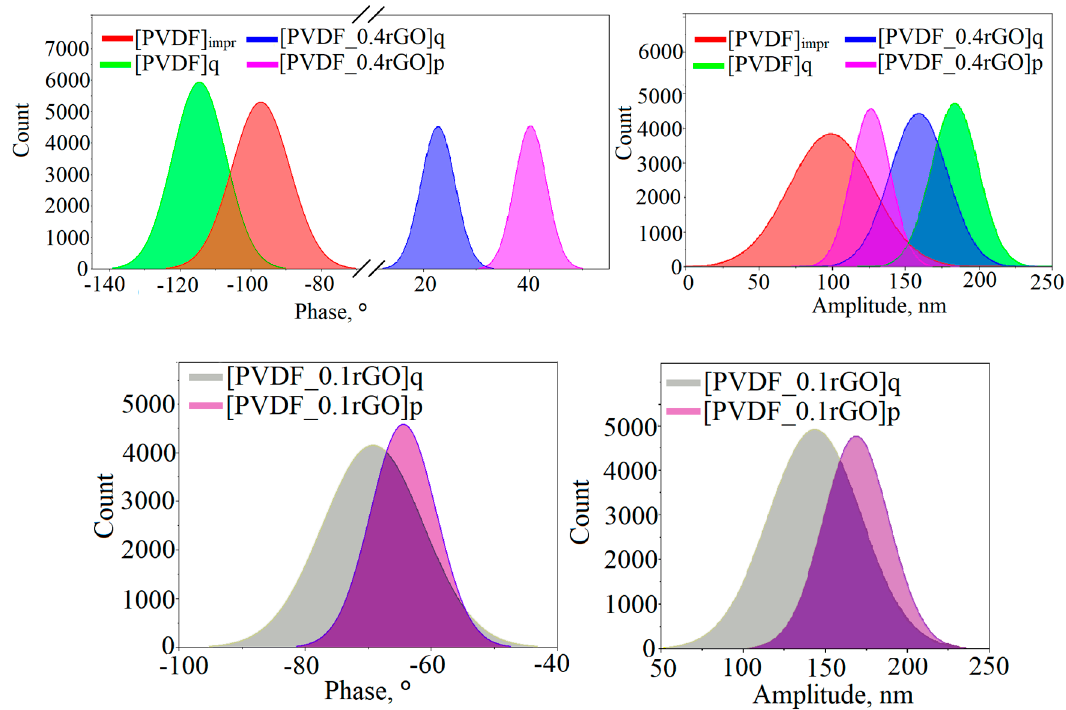
Figure 10. The statistical distribution of the PFM phase and amplitude values of the imprinted and quenched PVDF micropillars, micropillars with 0.4 wt % rGO (the measurements were carried out using an NSG03/TiN cantilever) and micropillars with 0.1 wt % rGO (FMG01 cantilever).